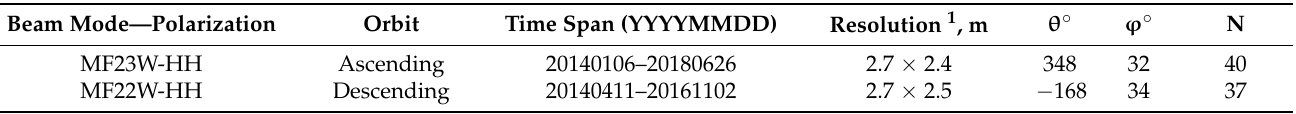
Table 1. Information used in the Small Baseline Subset (SBAS) and Multidimensional SBAS (MSBAS) processing ( θ ◦ , ϕ ◦ , and N are the azimuth, incidence angle, and number of single-look complexes (SLCs), respectively). Beam